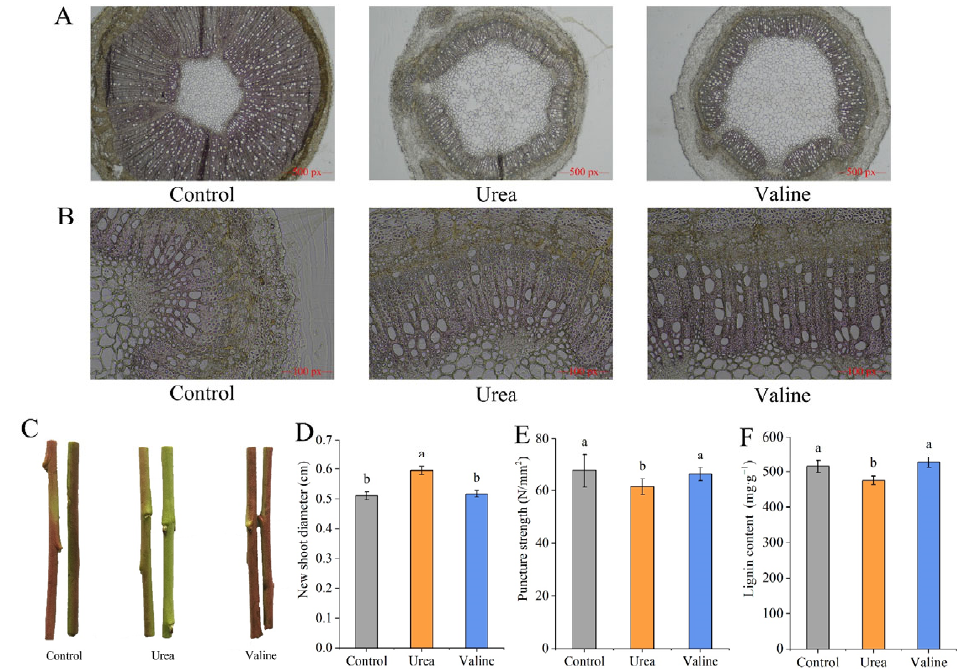
Figure 2. Effects of valine and urea on lignin content in new shoots of peach trees: ( A ) Effects of different treatments on phloroglucinol staining of peach new shoot; scale bar size is 500 px. ( B ) Effects of different treatments on phloroglucinol staining of peach new shoot; scale bar size is 100 px. ( C ) New shoot color. ( D ) New shoot diameter. ( E ) Puncture strength. ( F ) Lignin content. The error bar represents the standard deviation of the mean ( n = 3). Different lowercase letters indicate significant differences among treatments (Duncan test, p < 0.05).